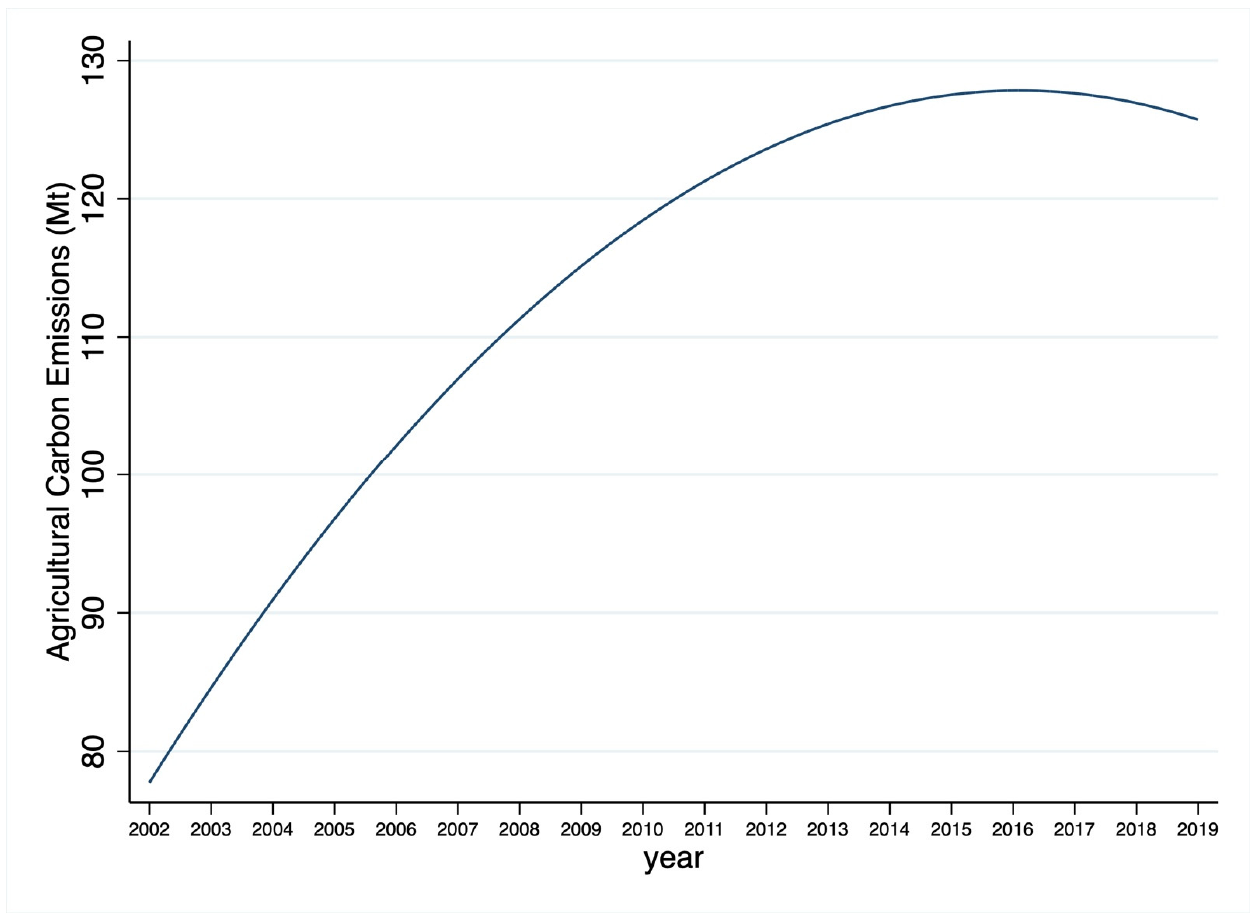
Figure 1. China’s agricultural carbon emissions over time (unit: Mt).